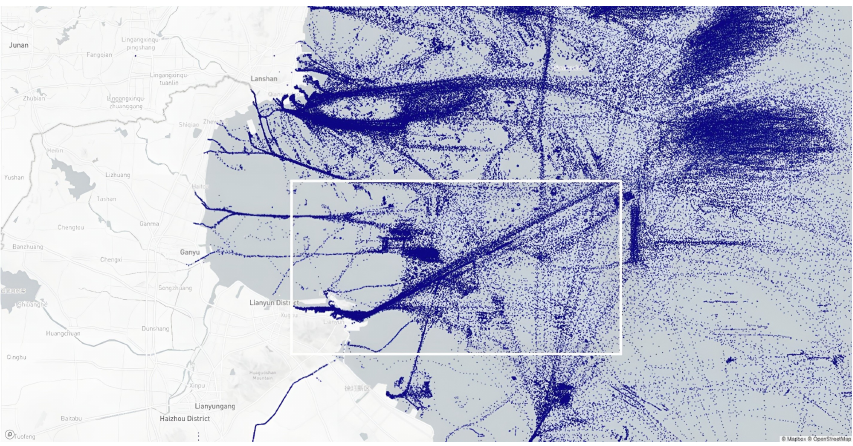
Figure 12. Sea area with obvious traffic flow characteristics.